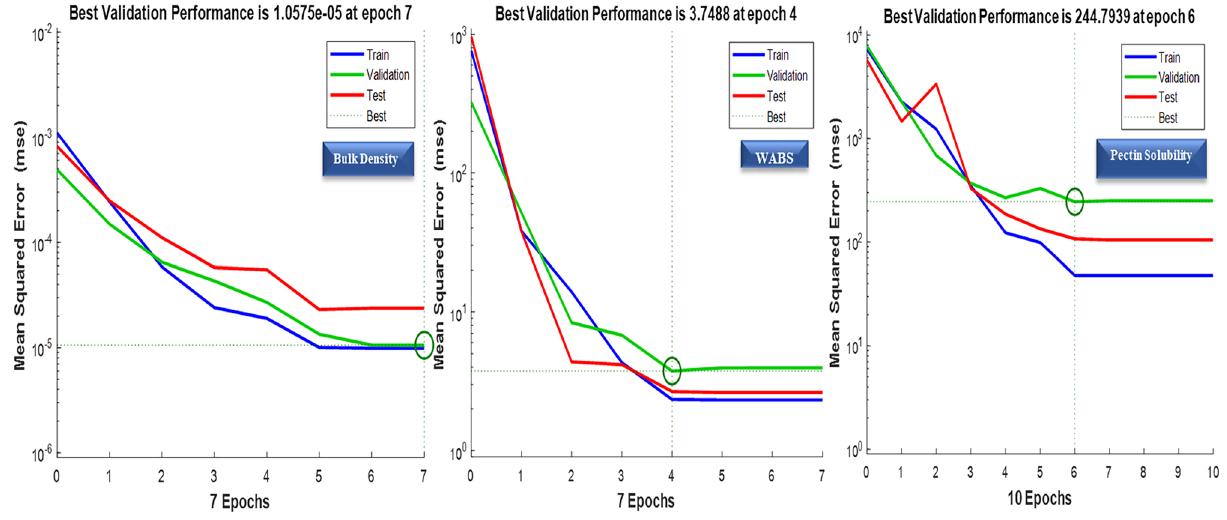
Figure 4. Validation means square error graphs of the chosen